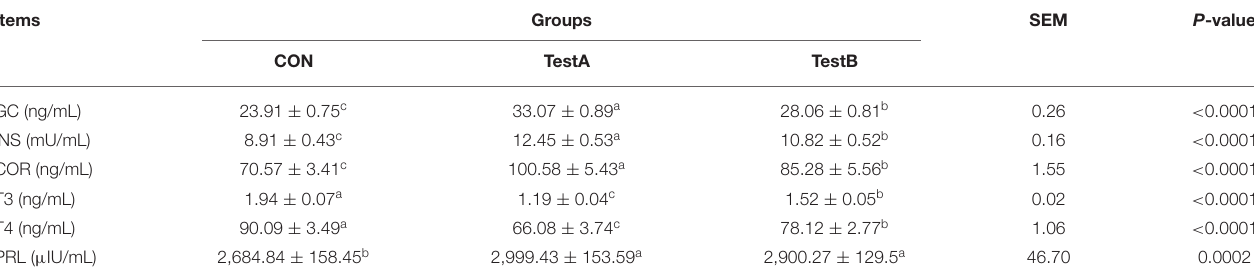
TABLE 6 | Effect of different Saccharomyces cerevisiae cultures on serum hormone indices in dairy cows.